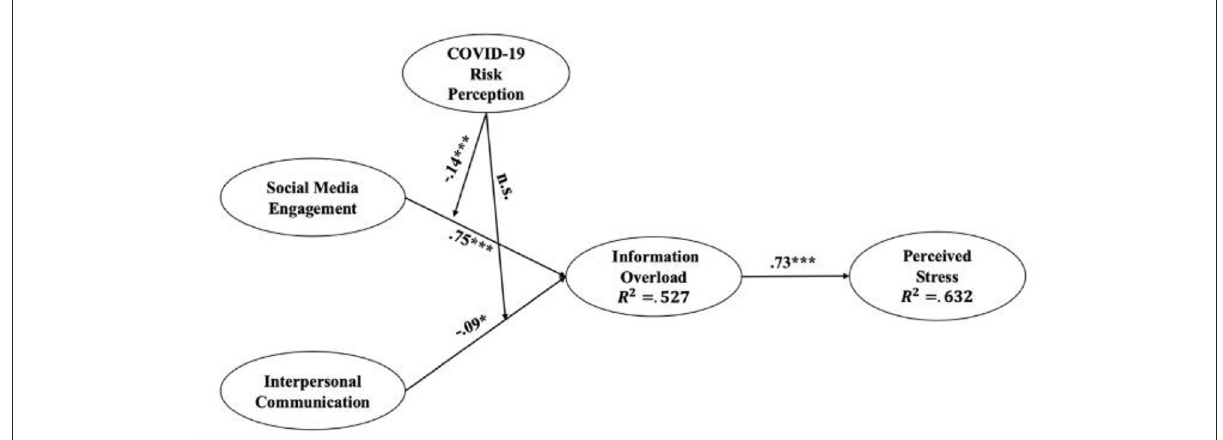
FIGURE2 Conceptual model after analysis. *: p < 0.05, **: p < < 0.01, ***: p <